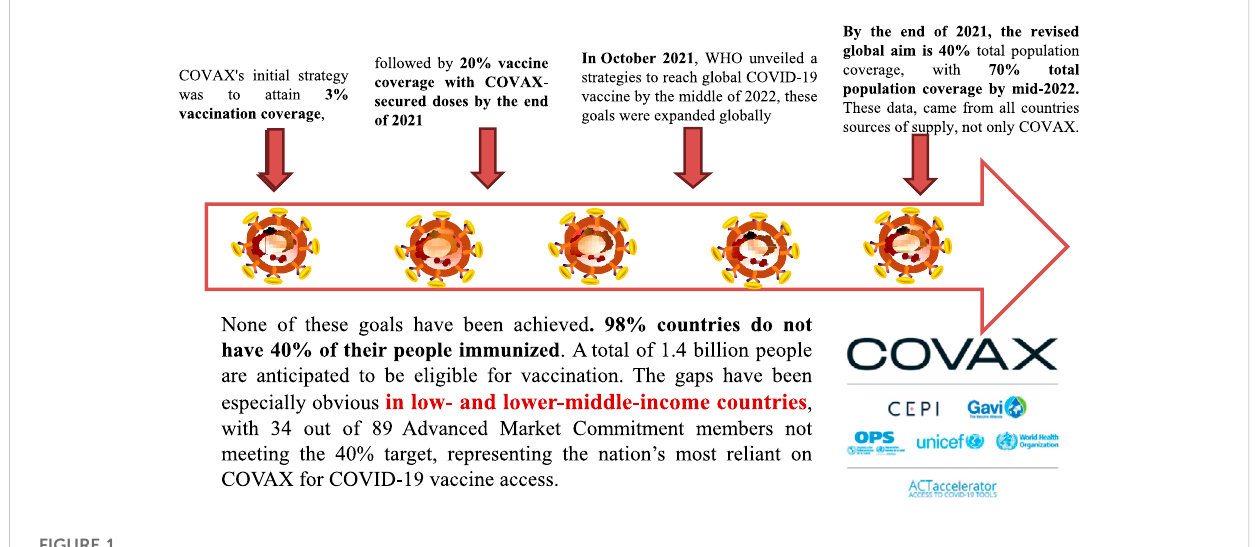
FIGURE 1 Flowcharts of “ WHO unveiled strategies to reach global COVID-19 vaccine ” . IAVG spearheaded the effort to achieve 70 percent coverage with COVID-19 vaccination rates in all nations as a global goals need. (Adapted from Knoll and Wonodi,